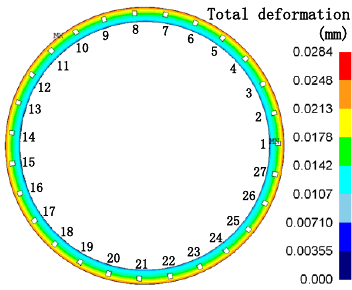
Figure 19. Deformation during drilling.